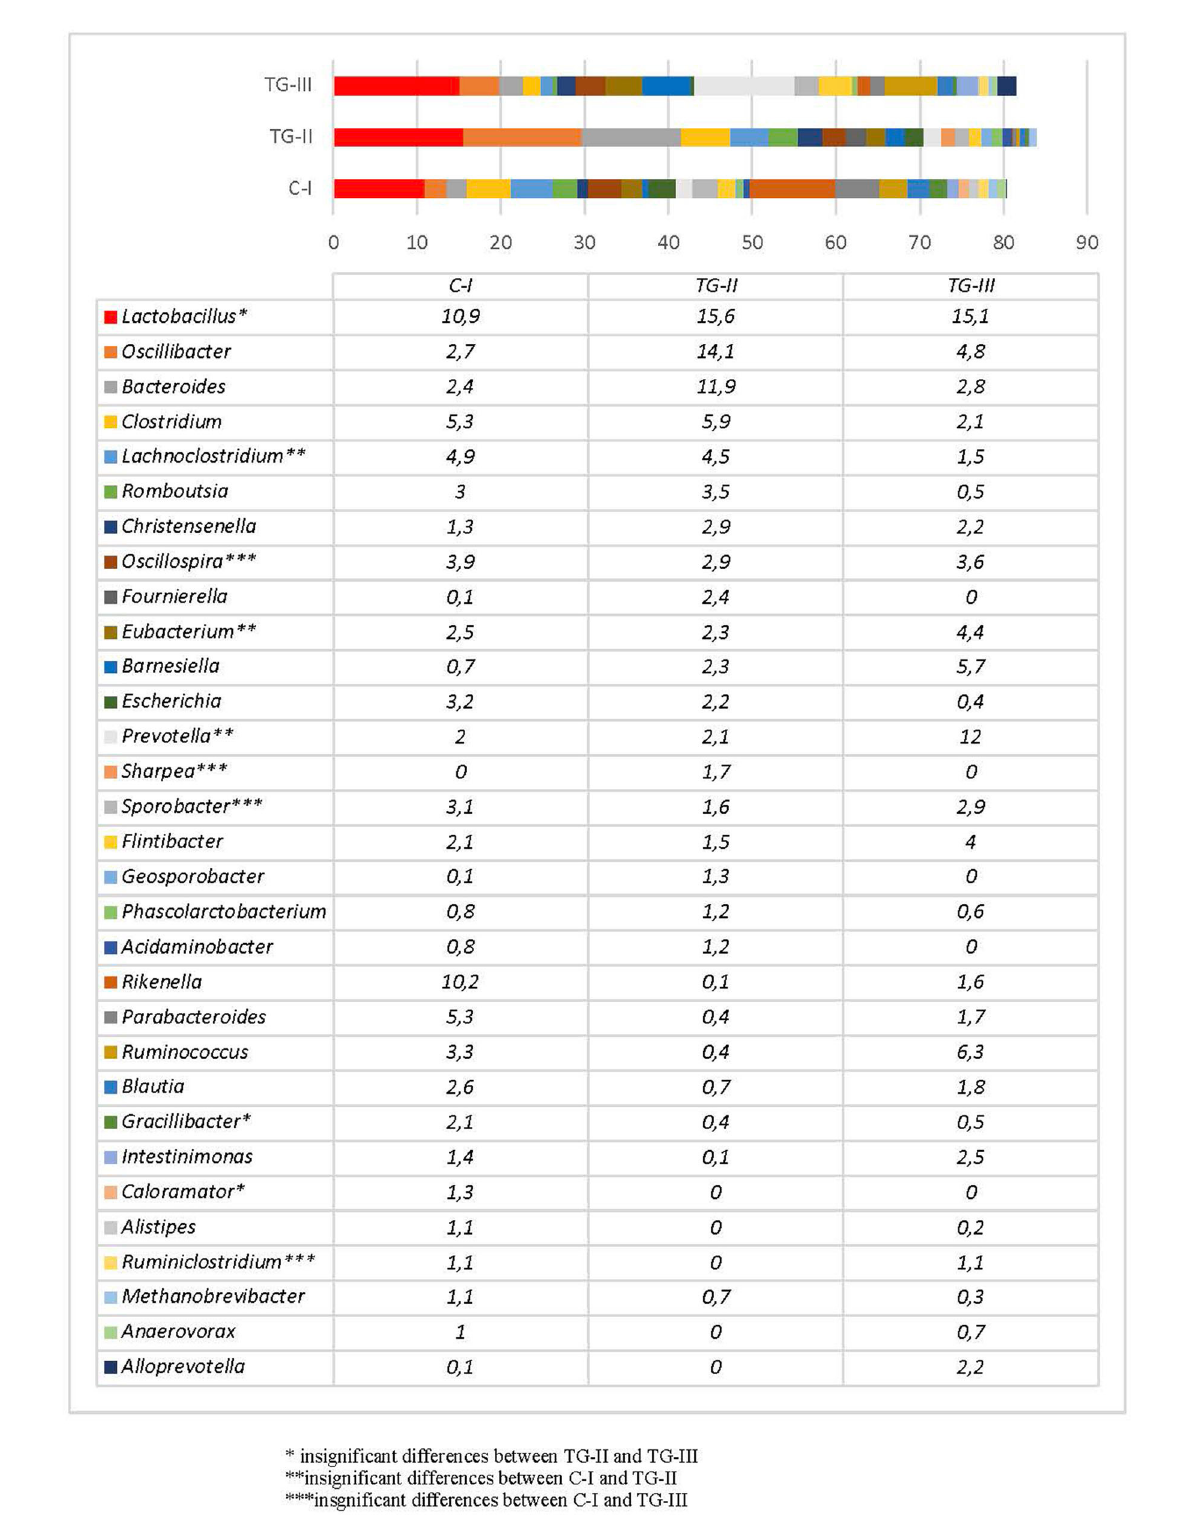
FIGURE4 Bacterial composition differences (%) between the animal groups at the end of the experiment [The most prevalent genera (prevalence of at least 1% out of the total amount of bacteria) are presented. (i) Basal diet (C-I – control group), (ii) basal diet with extruded-fermented wheat bran added (TG-II), (iii) basal diet with dried sugar beet pulp added (TG-III)] (* insignificant results between TG-II and TG-III, **insignificant results between C-I and TG-II, ***insignificant results between C-I and